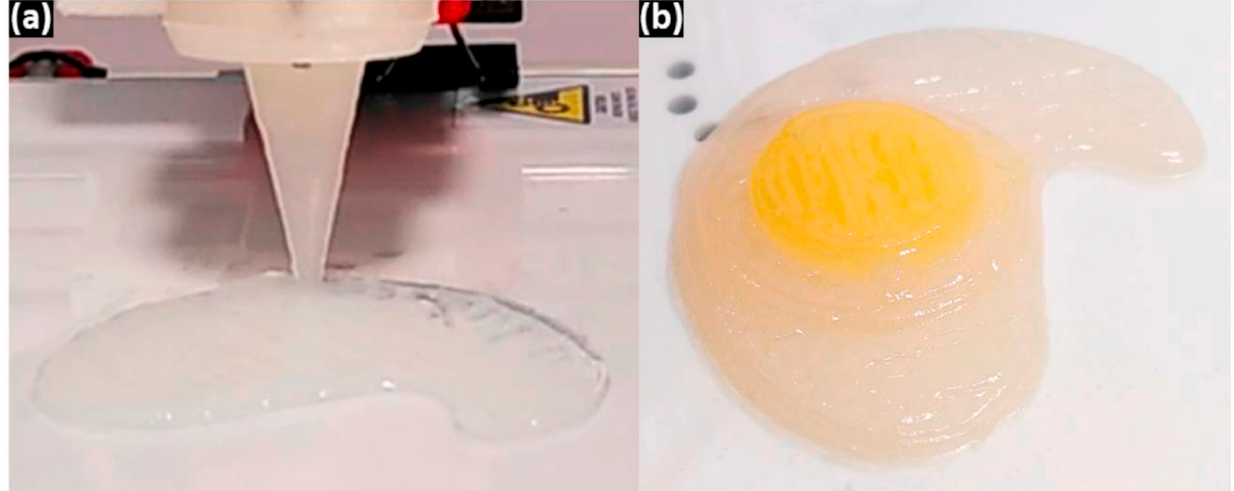
Figure 4. Printing of a simulated fried egg using thickened milk and orange juice showing ( a ) 3D printing nozzle ( b ) the 3D printed product (Reprinted with permission from Diañez et al., 2021 [26]. © 2021, Elsevier Ltd., Amsterdam, The Netherlands)